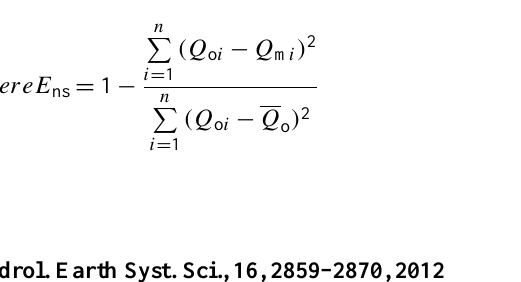
Fig. 3. The total amount of water flow (the best simulation and long term average annual values) and its relative change rate in the Heihe river basin. listed in Table 1. Two indices, the Nash-Sutcliffe coefficient (Eq. 3) and the coefficient of determination (Eq. 4), are used to evaluate the goodness of the calibration and